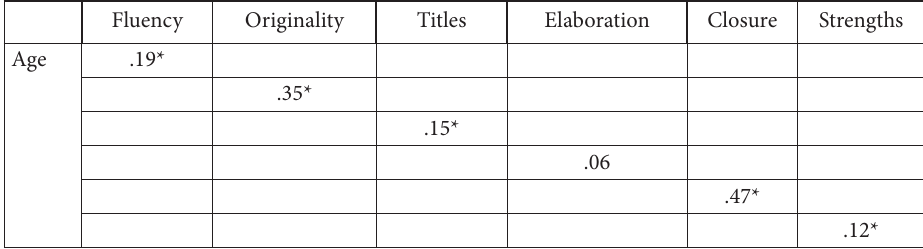
Table 6. Correlations between the age and Torrance Tests of Creative Thinking figural subscale scores of the students (source: created by